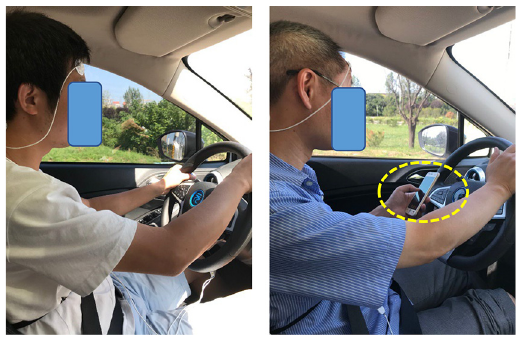
Figure 3 Regular driving (left) and distracted driving (right) in the